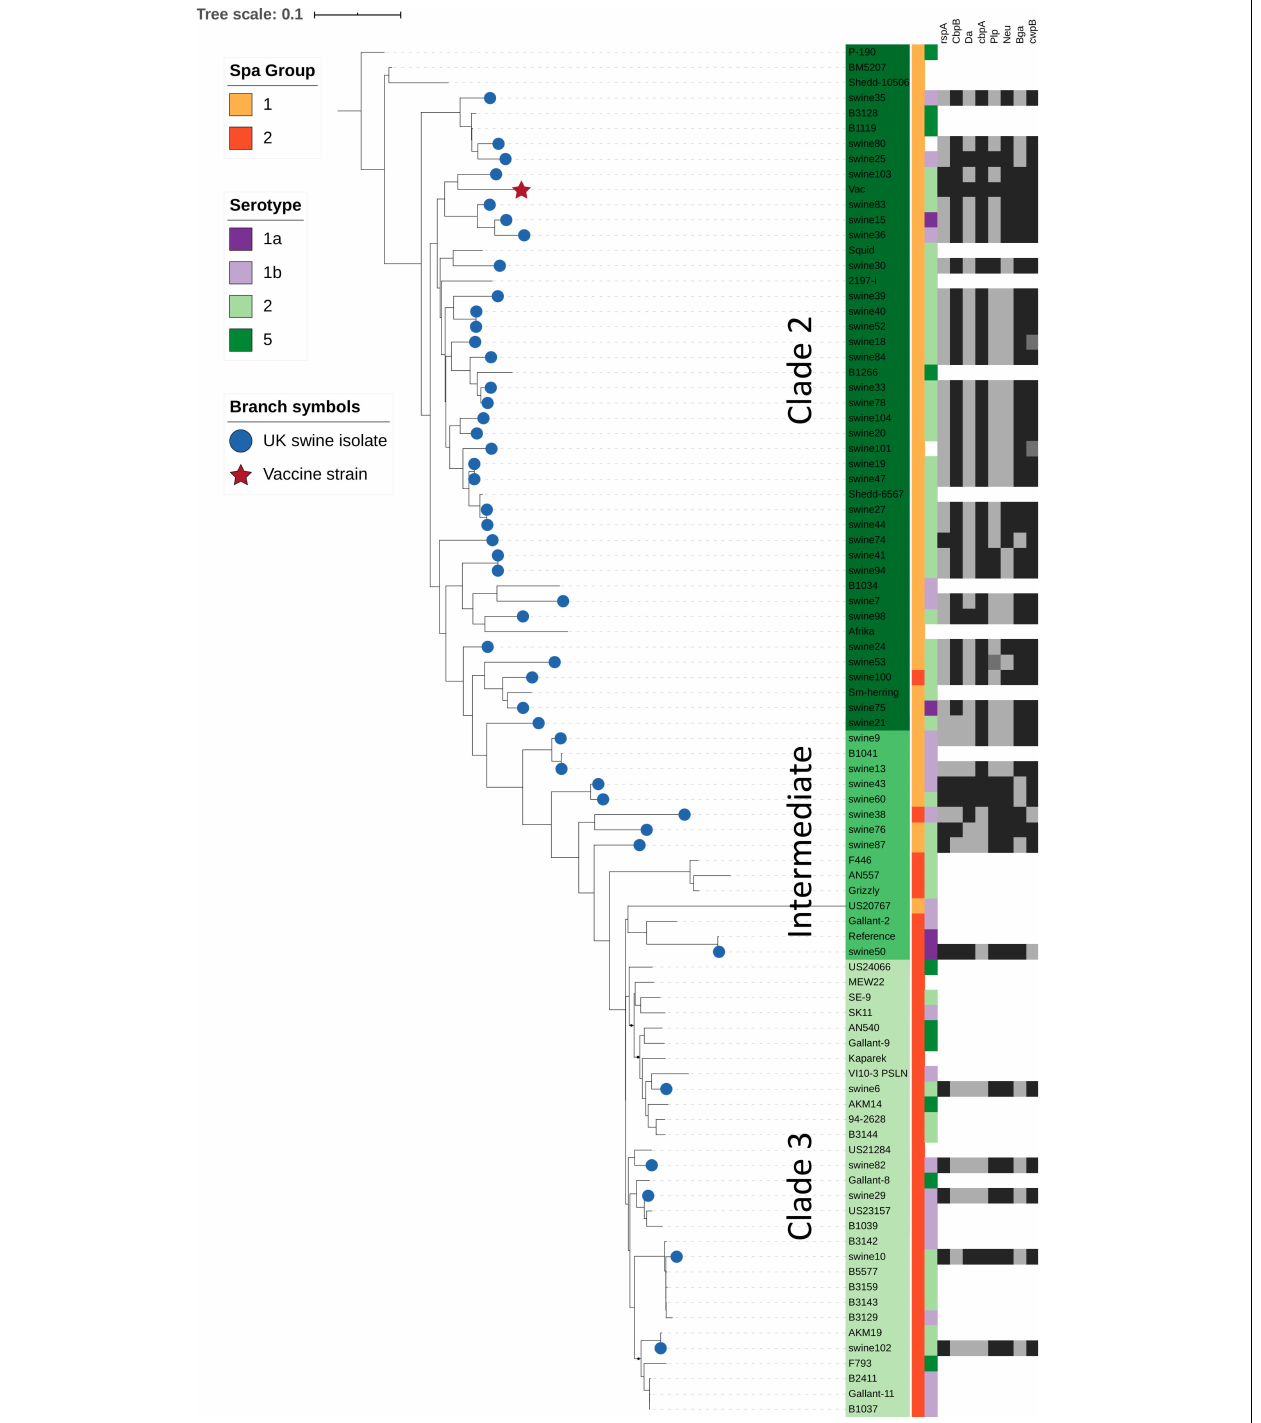
FIGURE 3 | Relationship of SpaA group, serotype, and immunogenic surface proteins to phylogenetic population structure. This phylogenetic tree is based on core single nucleotide polymorphisms (SNPs), and was estimated using the Nullarbor pipeline (same sequence data as in Figure 2 ). British pig isolates are represented by blue circles at branch tips, while the vaccine strain is represented by a red star. SpaA group (1 or 2) is shown by the yellow/orange color strip. Serotype (1a, 1b, 2, 5) as determined in silico is shown by the purple/green color strip. Those where phenotypic testing was not performed or where in silico test results differed are not shown. Variants of 8 different immunogenic surface proteins are shown by the black/gray color strips for all British pig isolates. Those shown in black are those which cluster most closely with the variant found in the vaccine strain; isolates in dark gray represent isolates with surface protein variants in outlier groups ( Supplementary Table S1 , Supplementary File S1